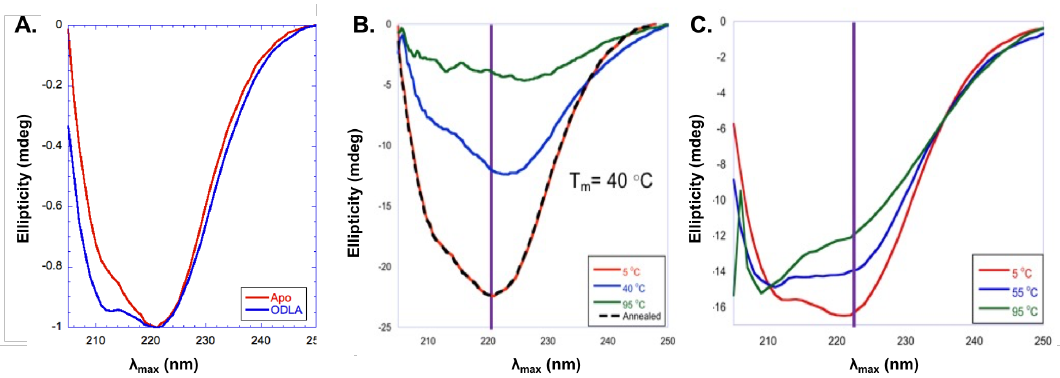
Figure 11. ( A ) Far-UV circular dichroism (CD) spectra of apo HepI (red), HepI with 100 µ M ADPH (dark green), and HepI with 100 µ M ODLA (blue) at 5 ◦ C. Far-UV CD Melt spectra of ( B ) apo HepI at 5 ◦ C (red), 40 ◦ C (blue), 95 ◦ C (green) and annealed at 5 ◦ C (black) and ( C ) HepI with 100 µ M ODLA 5 ◦ C (red), 40 ◦ C (blue) and 95 ◦ C (green). Purple lines demonstate changes in ellipticity at 222